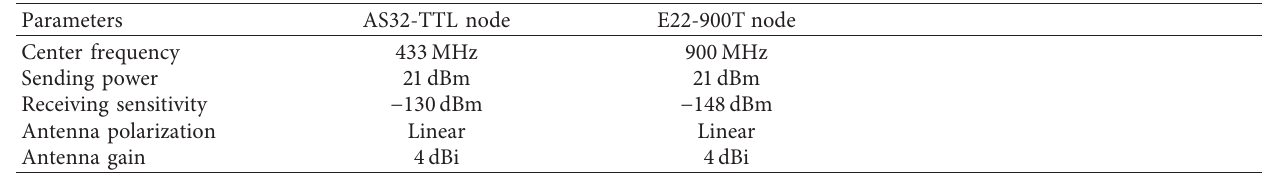
Table 4: Experimental settings: details of LoRa nodes.